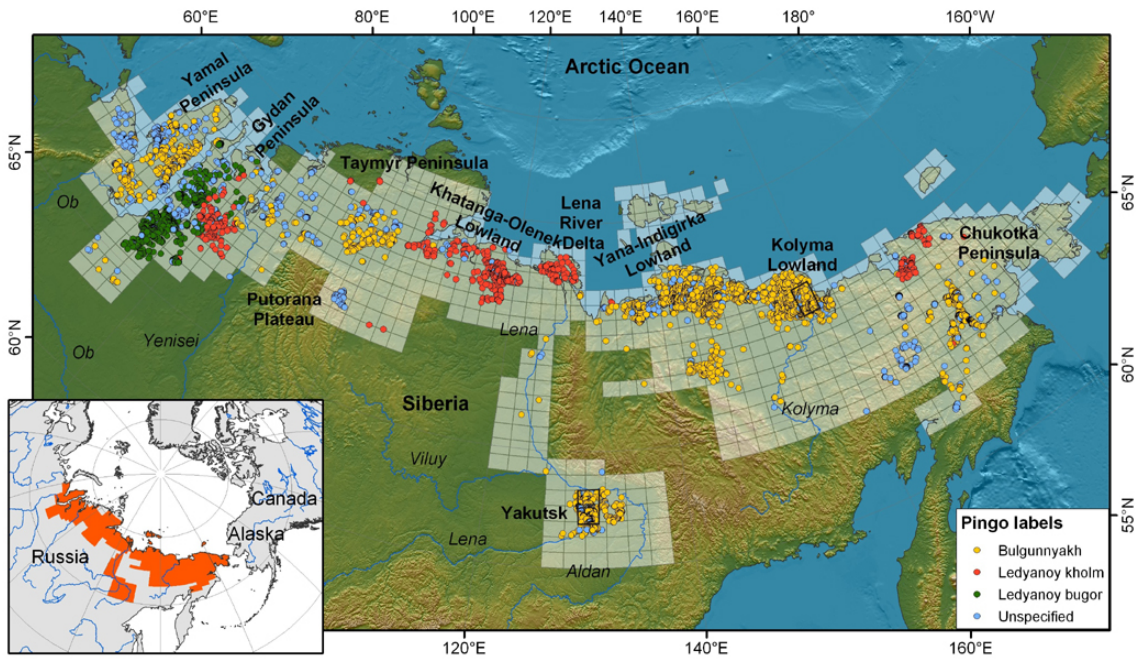
Fig. 2. Location of study region in North Asia (map inset) and distribution of 6059 pingos (large map) digitized from 675 topographic maps 1:200000 (red area in map inset and light semitransparent frames in large map). Small black frames mark the outlines of subregions shown in Fig. 6 (Yakutsk and Kolyma Lowland).